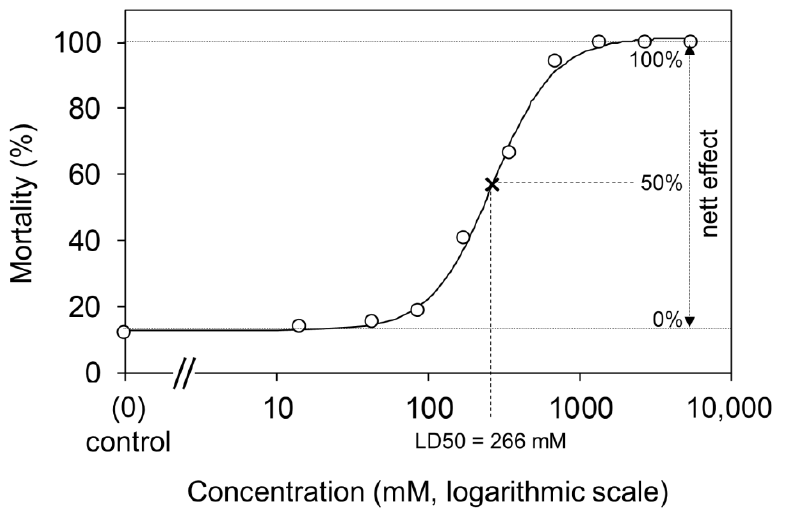
Figure 3. Concentration-response curve and LD50 concentration value for lithium chloride in poultry red mite. Note that LD50 value was calculated based on the net effect of the tested substance (i.e., mortality above the control level).